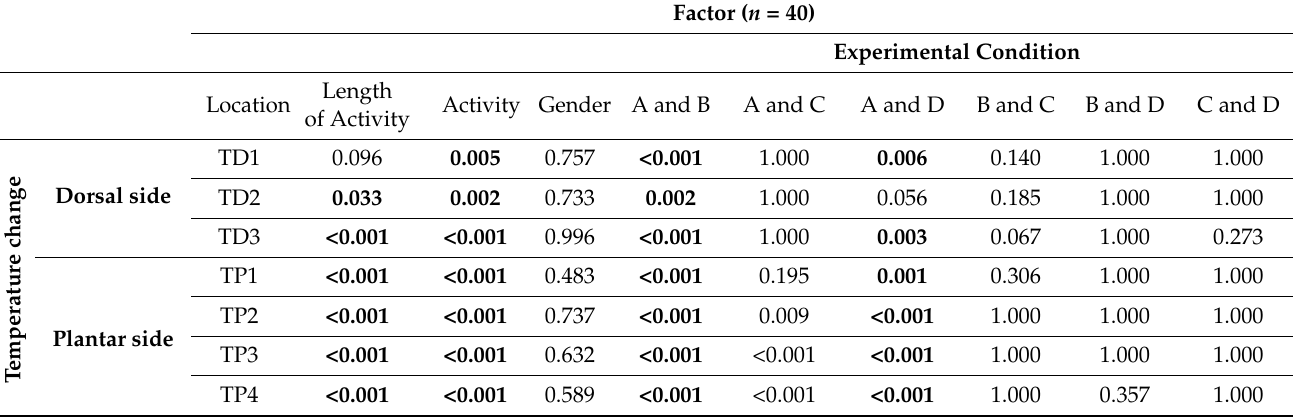
Table 2. Summary of effects of different factors on changes in skin temperature, relative humidity, and sweat accumulation. Factor ( n =